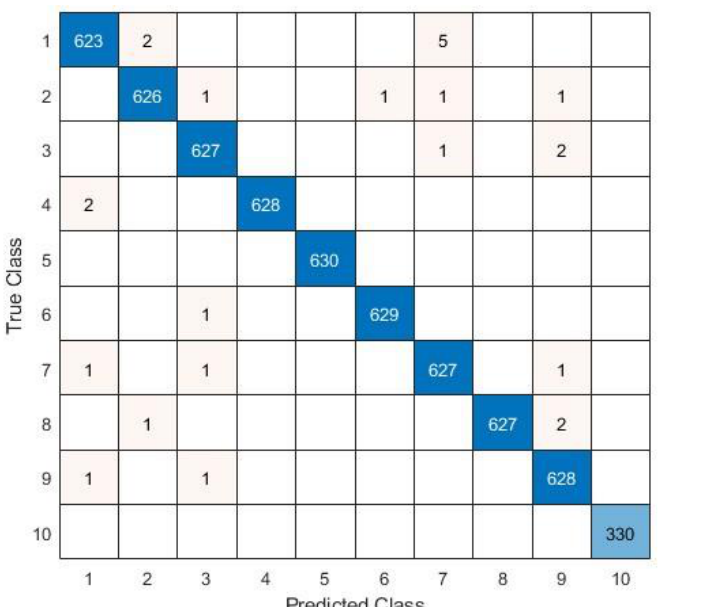
Figure 19. The training performance.